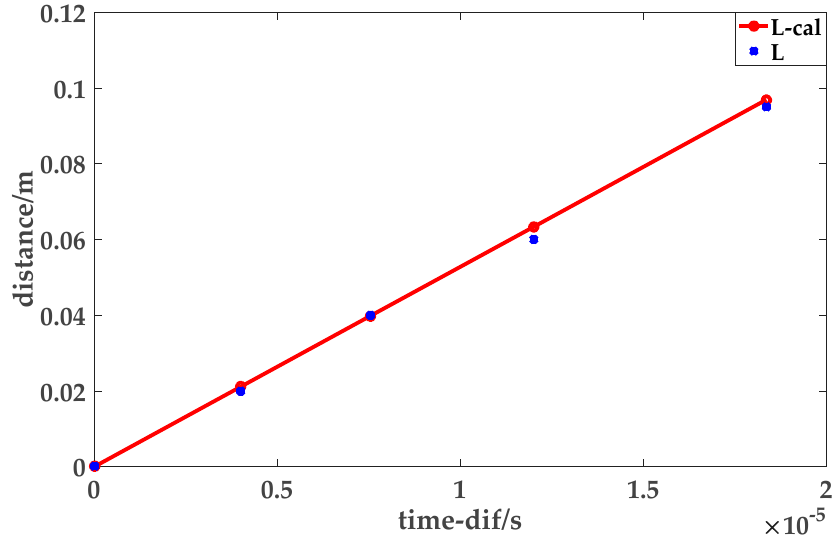
Figure 3. Single mode signal received in non-damaged sheet.